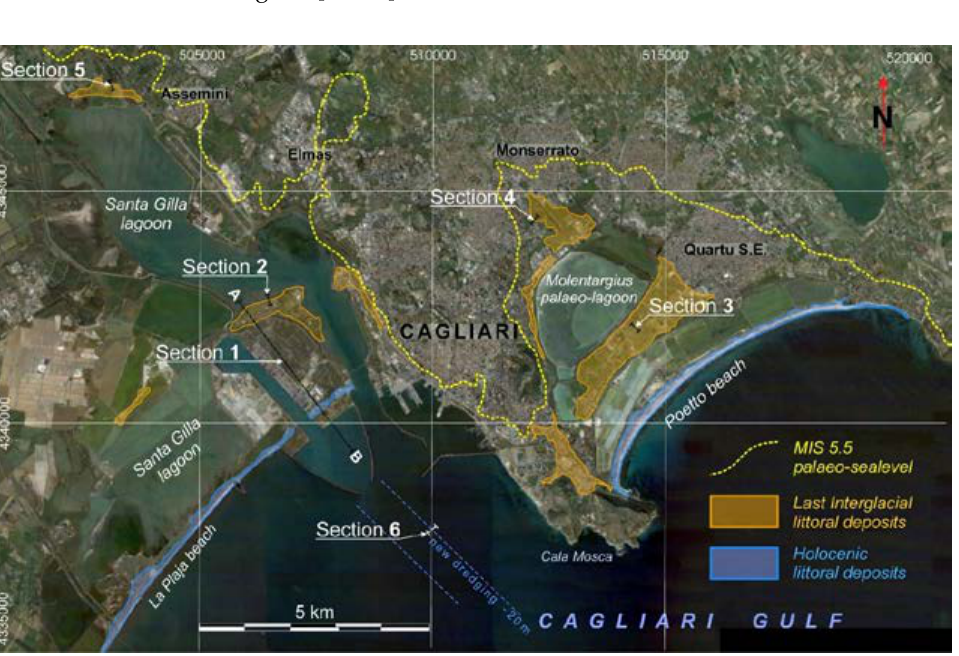
Figure 3. Aerial photograph of the coastal plain of Cagliari showing the main geomorphological features, yellow dashed line indicates the paleo high sea level of MIS 5.5 “Tirreniano”; the littoral deposits of the last interglacial (LI) and the Holocenic shore deposits. Location of MIS5 stratigraphic sections: Section (1), geological profile crosses the container port for 4 km; Section (2), the north face of a large paleo barrier island of the MIS 5.5 of Sa Illetta in front of Santa Gilla lagoon [23]; Section (3), located in a quarry in the littoral paleo spit of Is Arenas; Section (4) and (5) , marine terraces at the inner margin of the MIS5.5 transgression overlapping fluvial deposits of MIS 6; Section (6). MIS5 deposits intercepted from the dredging embankment at − 16.5 m, 4 m below in the seabed.